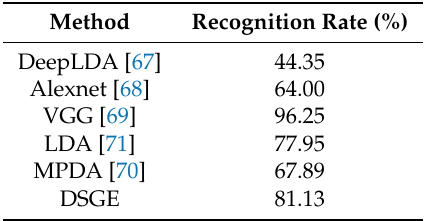
Table 10. The recognition results of di ff erent methods on the PubFig 83